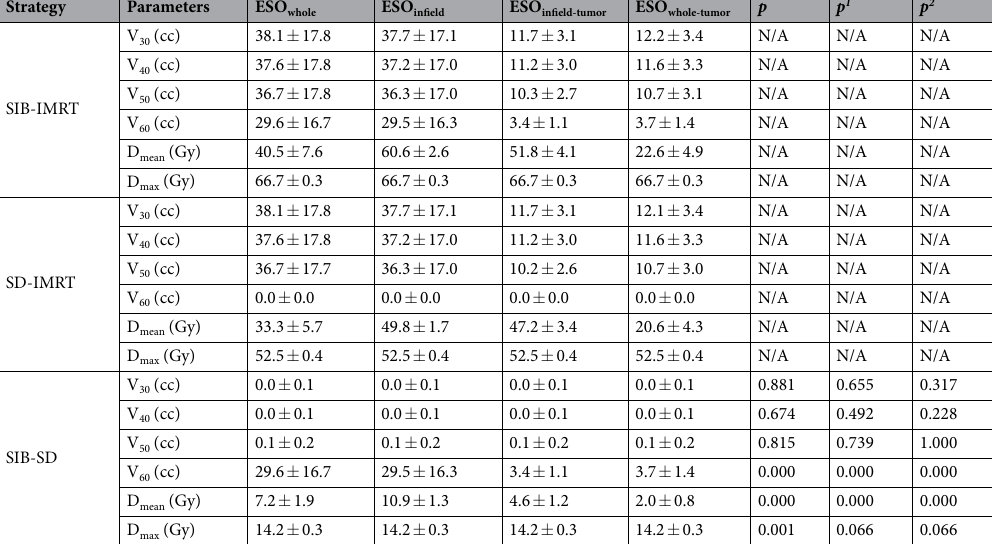
Table 2. Esophageal dose changes for four DEs. Abbreviations: SIB-IMRT = intensity-modulated radiation therapy with simultaneous integrated boost; SD-IMRT = standard-dose intensity-modulated radiation therapy; SIB-SD = the difference between the SIB-IMRT and SD-IMRT plans; ESO whole = the entire esophagus, including the tumor; ESO infield = the portion of ESO whole within the treatment field; ESO infield-tumor = the portion of ESO infield , excluding the tumor; ESO whole-tumor = the portion of ESO whole , excluding the tumor. D mean = mean dose; D max = maximum dose; V x = the volume of the organ receiving a dose of x or more. N/A = not available. p 1 : ESO